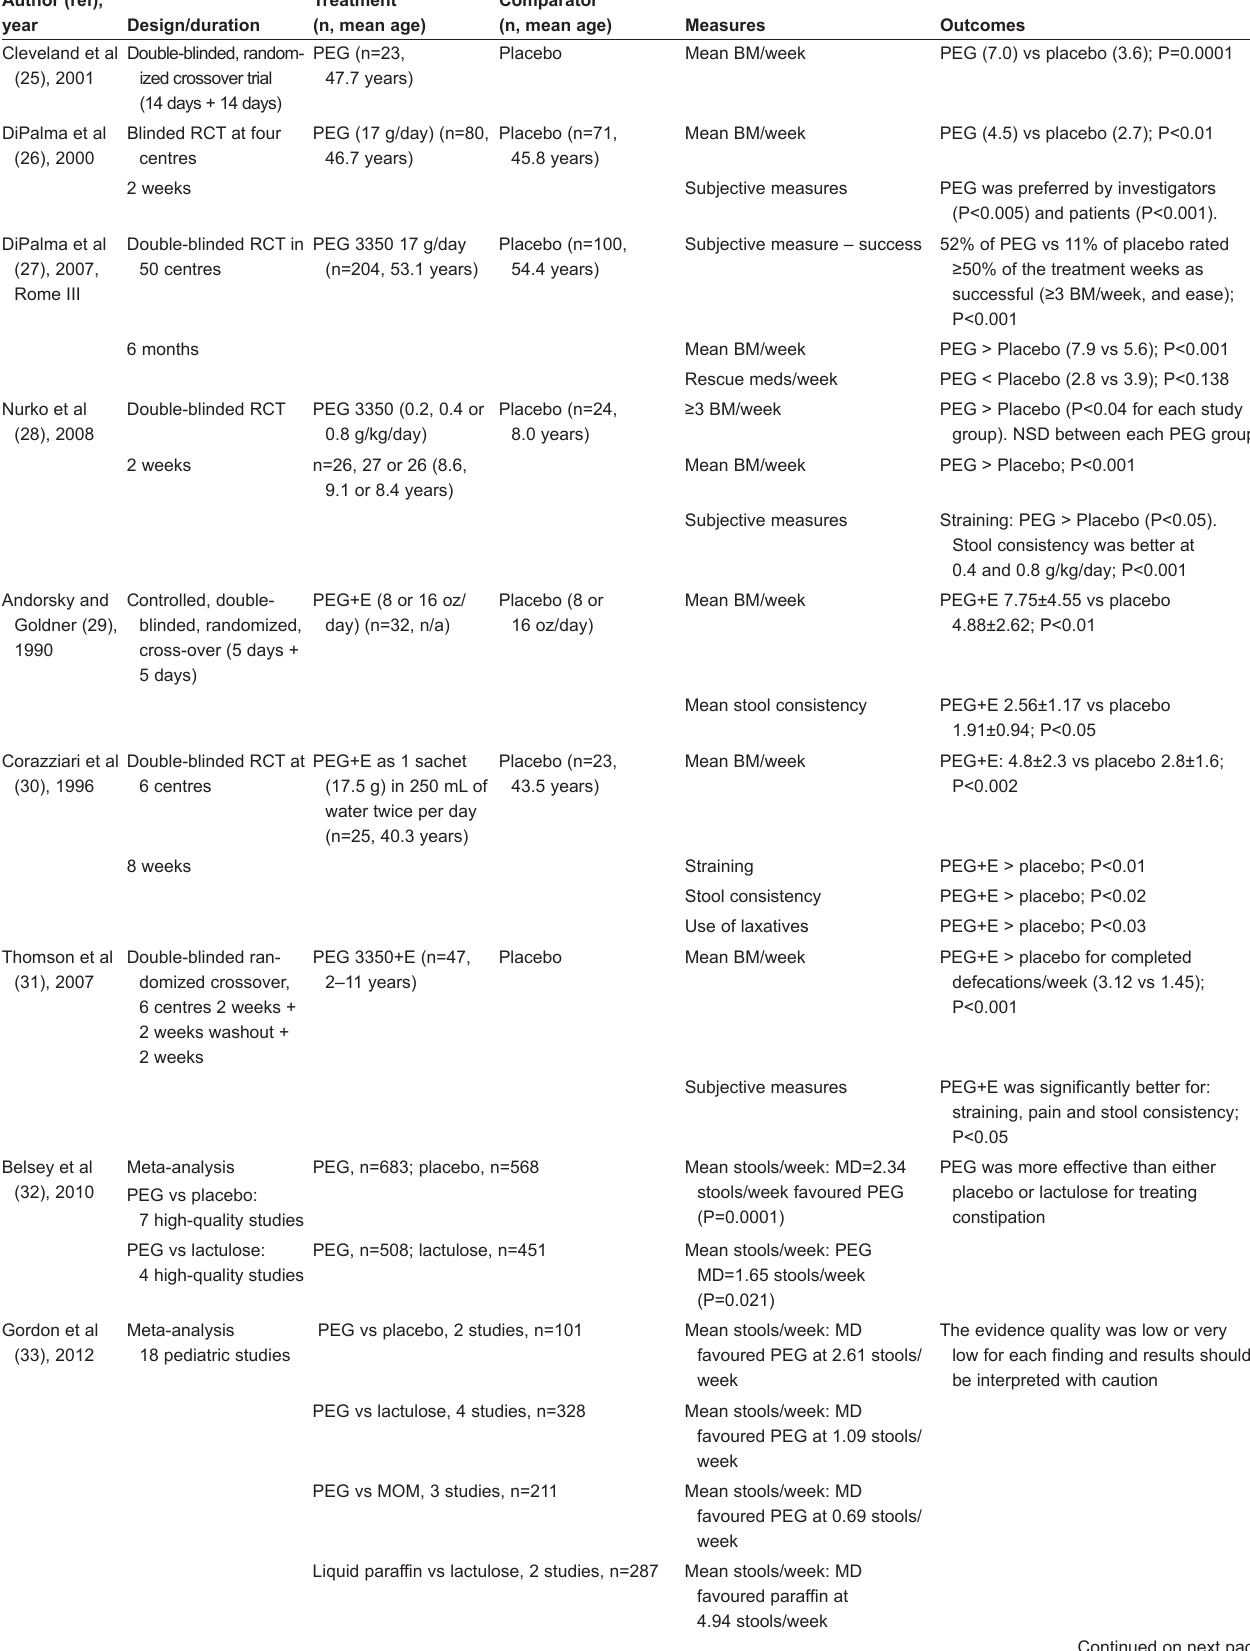
Table 2 Summary of studies examining the efficacy of nonstimulant